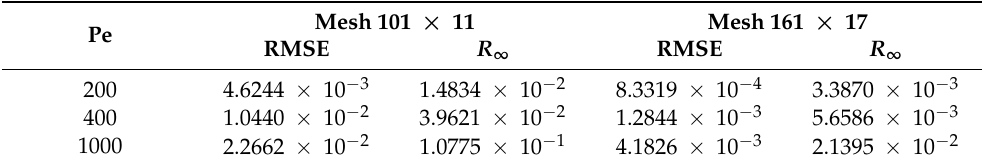
Table 8. Example No. 3—RMSE and R ∞ for different Peclet numbers.